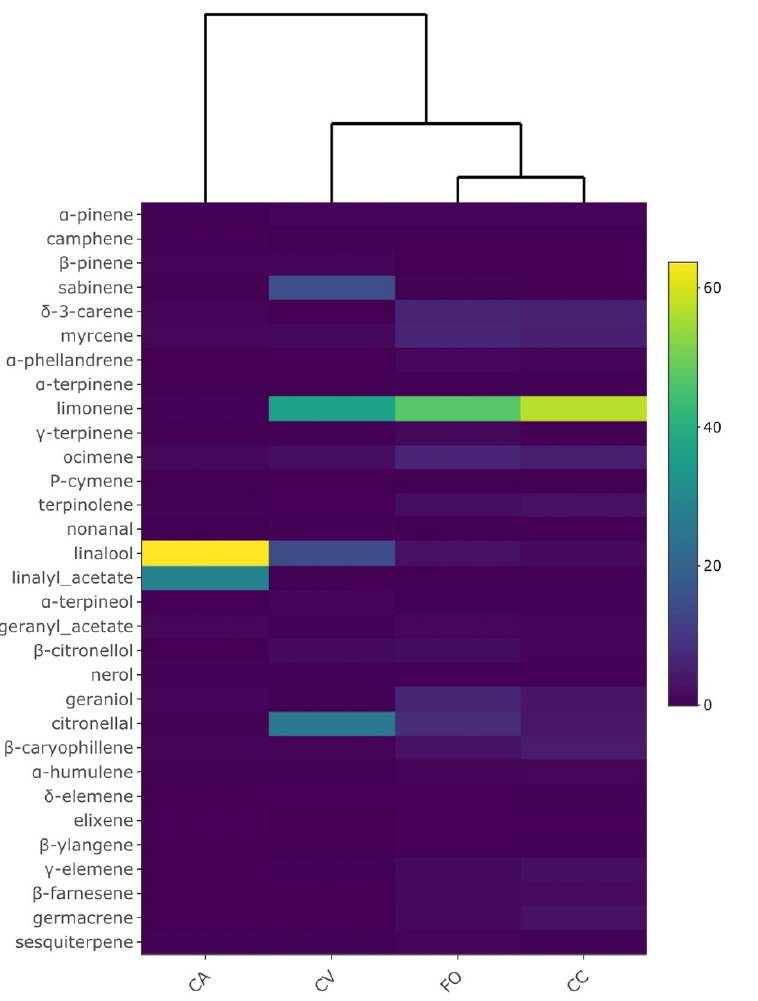
Figure 4. Heatmap on plant secondary metabolites sequestered in the leaves of Citrus volkameriana (CV), Forner-Alcaide no. 5 (FO), Carrizo citrange (CC), and Citrus aurantium (CA). The heatmap legend (right) indicates the abundance (low—blue; high—yellow) of metabolites recorded in each sample.